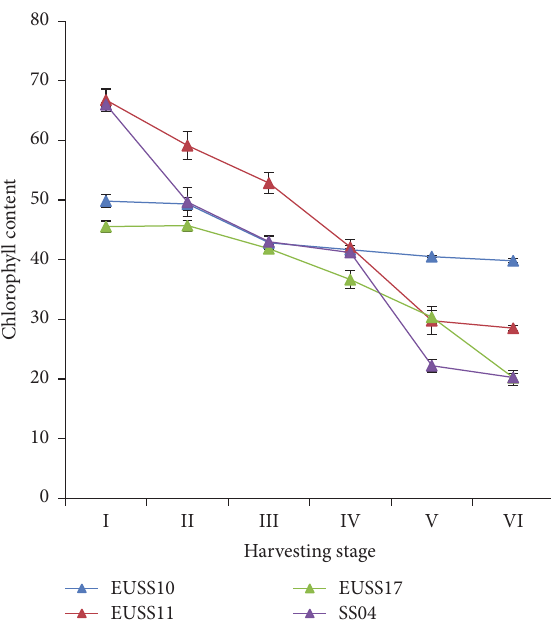
Figure 2: Effect of harvesting stage on chlorophyll content of four sweet sorghum genotypes evaluated in part of western Kenya.